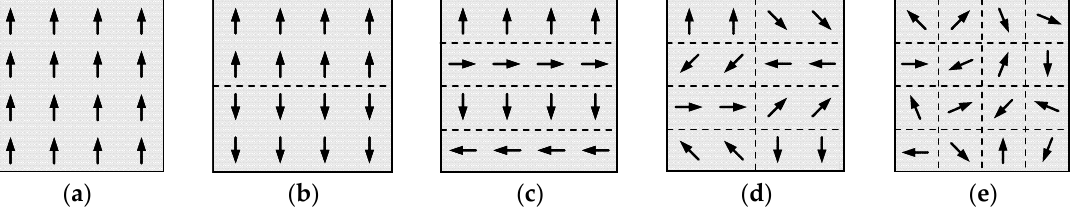
Figure 7. Division of a system of 16 elements into equal parts according to the “direction of motion” attribute: ( a ) N = 1; ( b ) N = 2; ( c ) N = 4; ( d ) N = 8; ( e ) N =